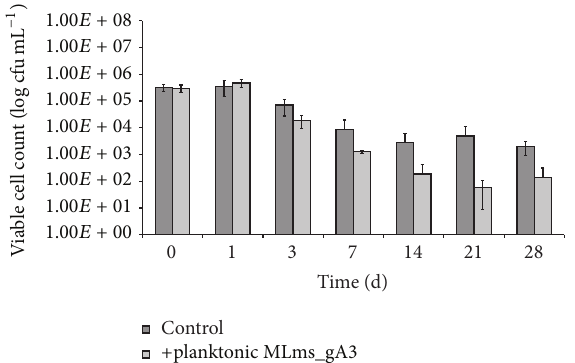
Figure 1: Logarithmic presentation of V. anguillarum viable cell counts [cfumL −1 ] over a period of 28 days in the presence of plank- tonic Pseudoalteromonas sp. strain MLms gA3 cells (light grey bars). Viable V. anguillarum obtained without the Pseudoalteromonas strain served as the control (dark grey bars). The starting inoculum of V. anguillarum was for all experiments ∼ 10 5 cfu mL −1 ; see Table 2 for definite